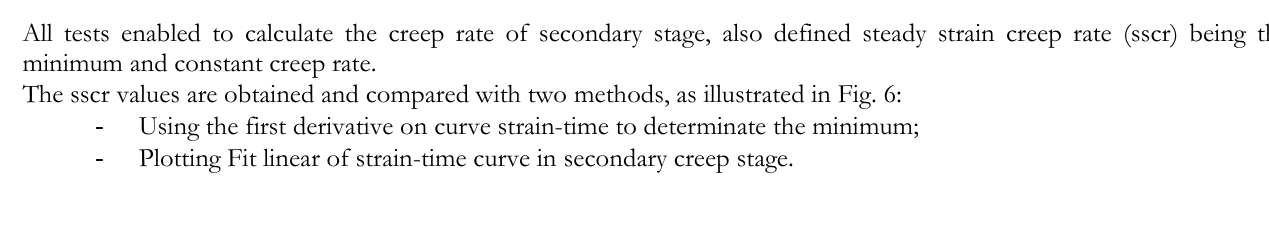
Figure 5: Comparison between creep curves in air at 300, 400 and 500 MPa, until